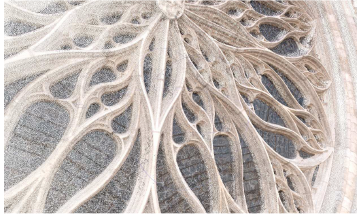
Figure 9 : zoom into the 3D point clouds from 15 mm images A 3D model was also calculated with the 105 mm focal length images (Figure 10a). The orientation values calculated with Redresseur software were converted into the MicMac format.